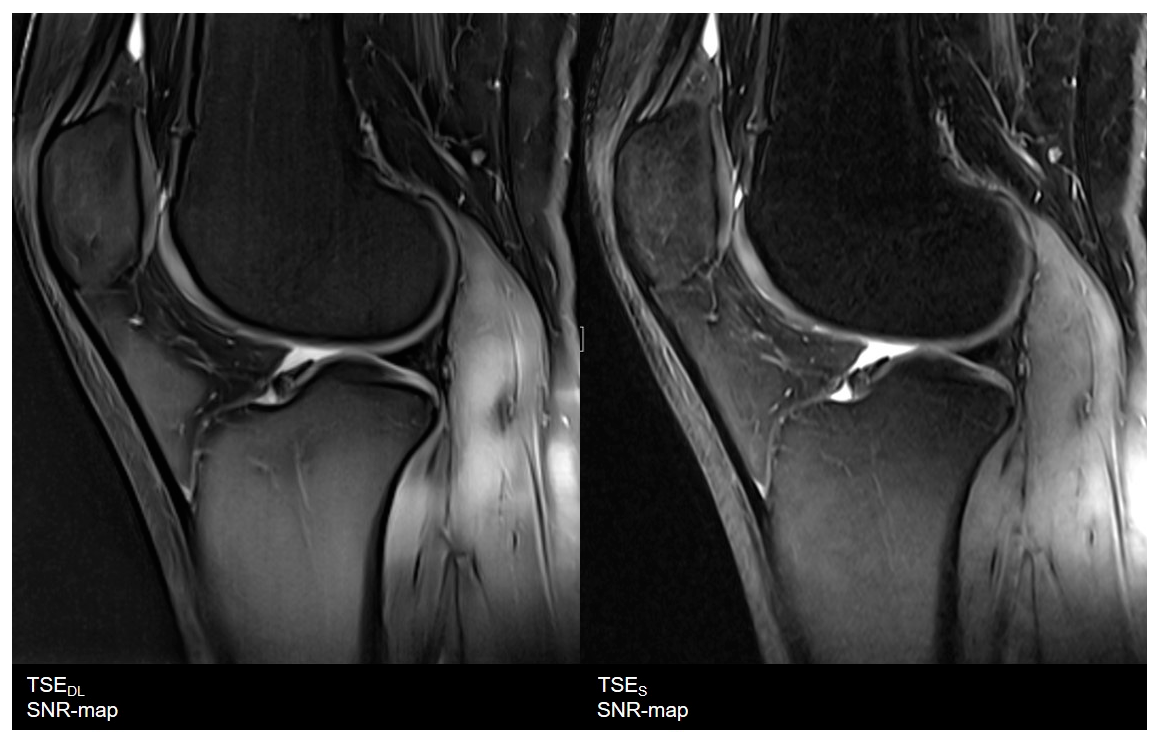
Figure 11. Exemplary visualization of signal-to-noise ratio (SNR) as SNR-maps. On the ( left ), results of the TSE DL dataset, and on the ( right ), of a TSE S dataset of knee in sagittal orientation. The TSE DL dataset shows lower noise levels and an increase of SNR with a more homogeneous distribution compared to the TSE S dataset. In addition, SNR levels throughout the whole image are more homogeneous.